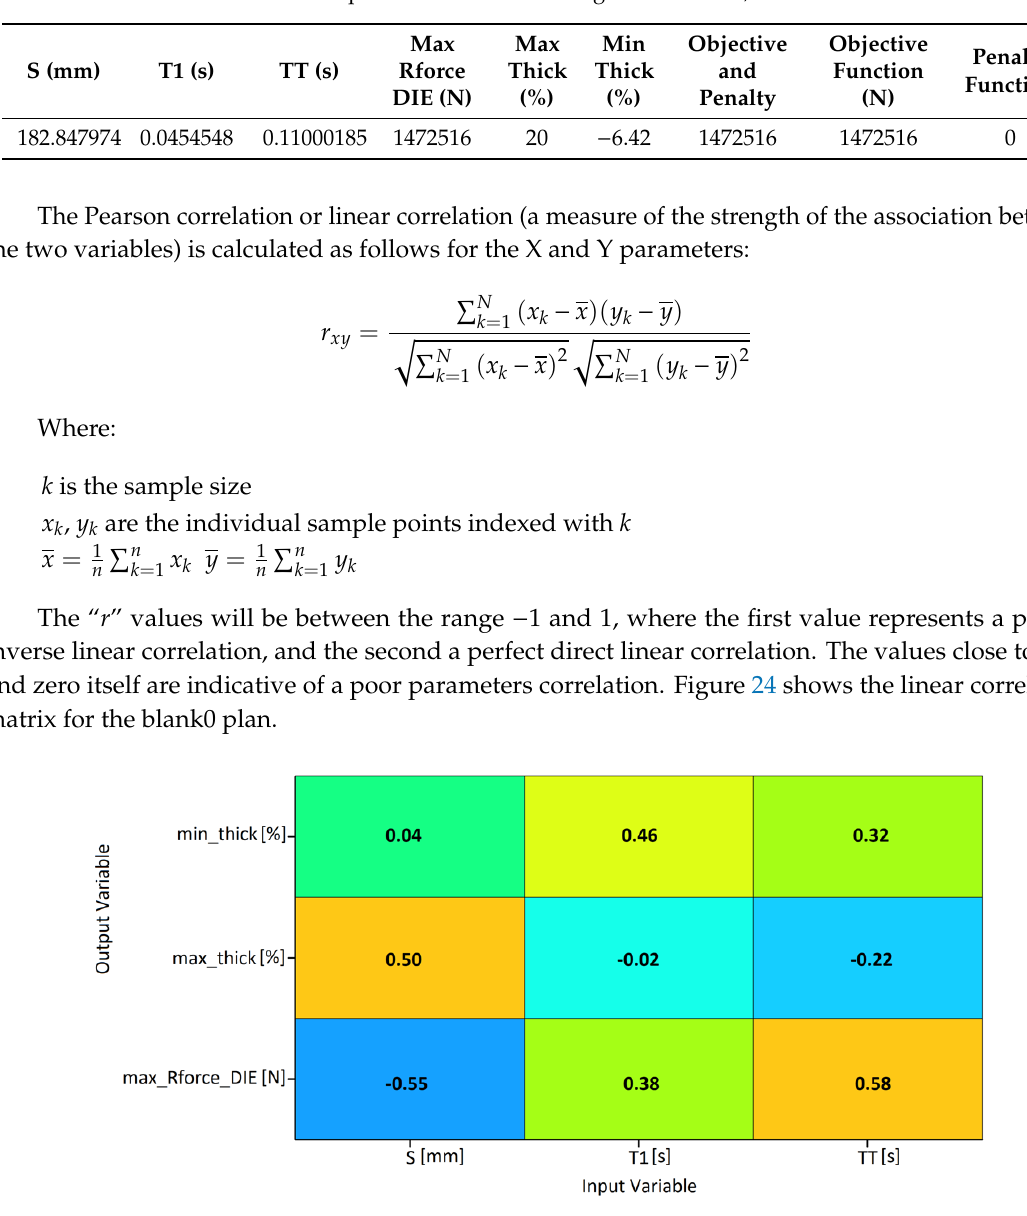
Figure 24. Linear correlation matrix for the blank0 plan.